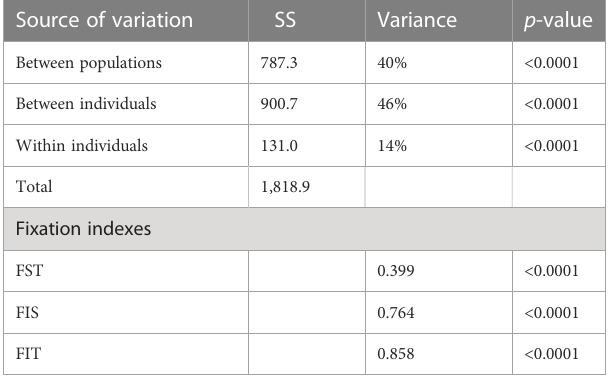
(orange), and D (yellow) were observed, having consistent